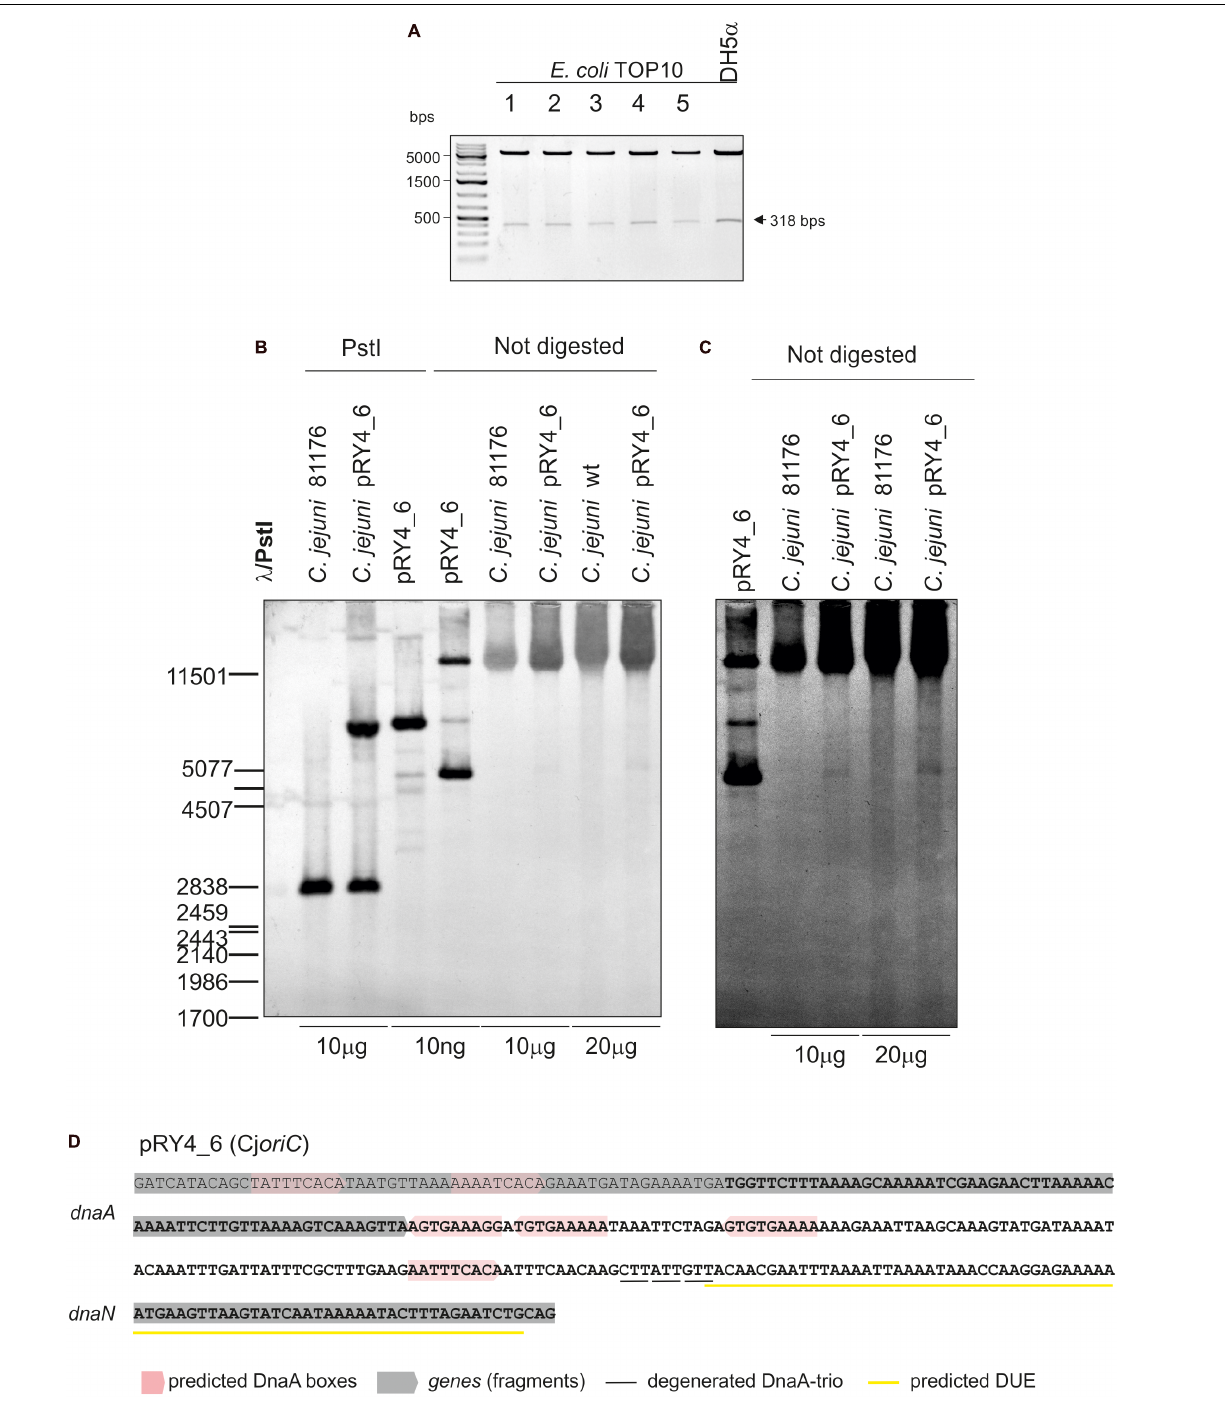
FIGURE 2 | Analysis of pRY4_6 self-replication in C. jejuni . (A) Gel analysis of plasmids isolated from E. coli TOP10 cells transformed with genomic DNA of C. jejuni pRY4_6 conjugant strain. Plasmids were digested by EcoRI and PstI. The plasmid propagated in E. coli DH5a is shown as a control. (B) Southern blot analysis of C. jejuni pRY4_6 conjugant strain. C. jejuni 81176 wild type and C. jejuni pRY4_6 conjugant strains genomic DNA and the pRY4_6 plasmid, isolated from E. coli , undigested or digested with PstI, were resolved in 1% agarose gel (Supplementary Figure S3), transferred onto a nylon membrane and probed with